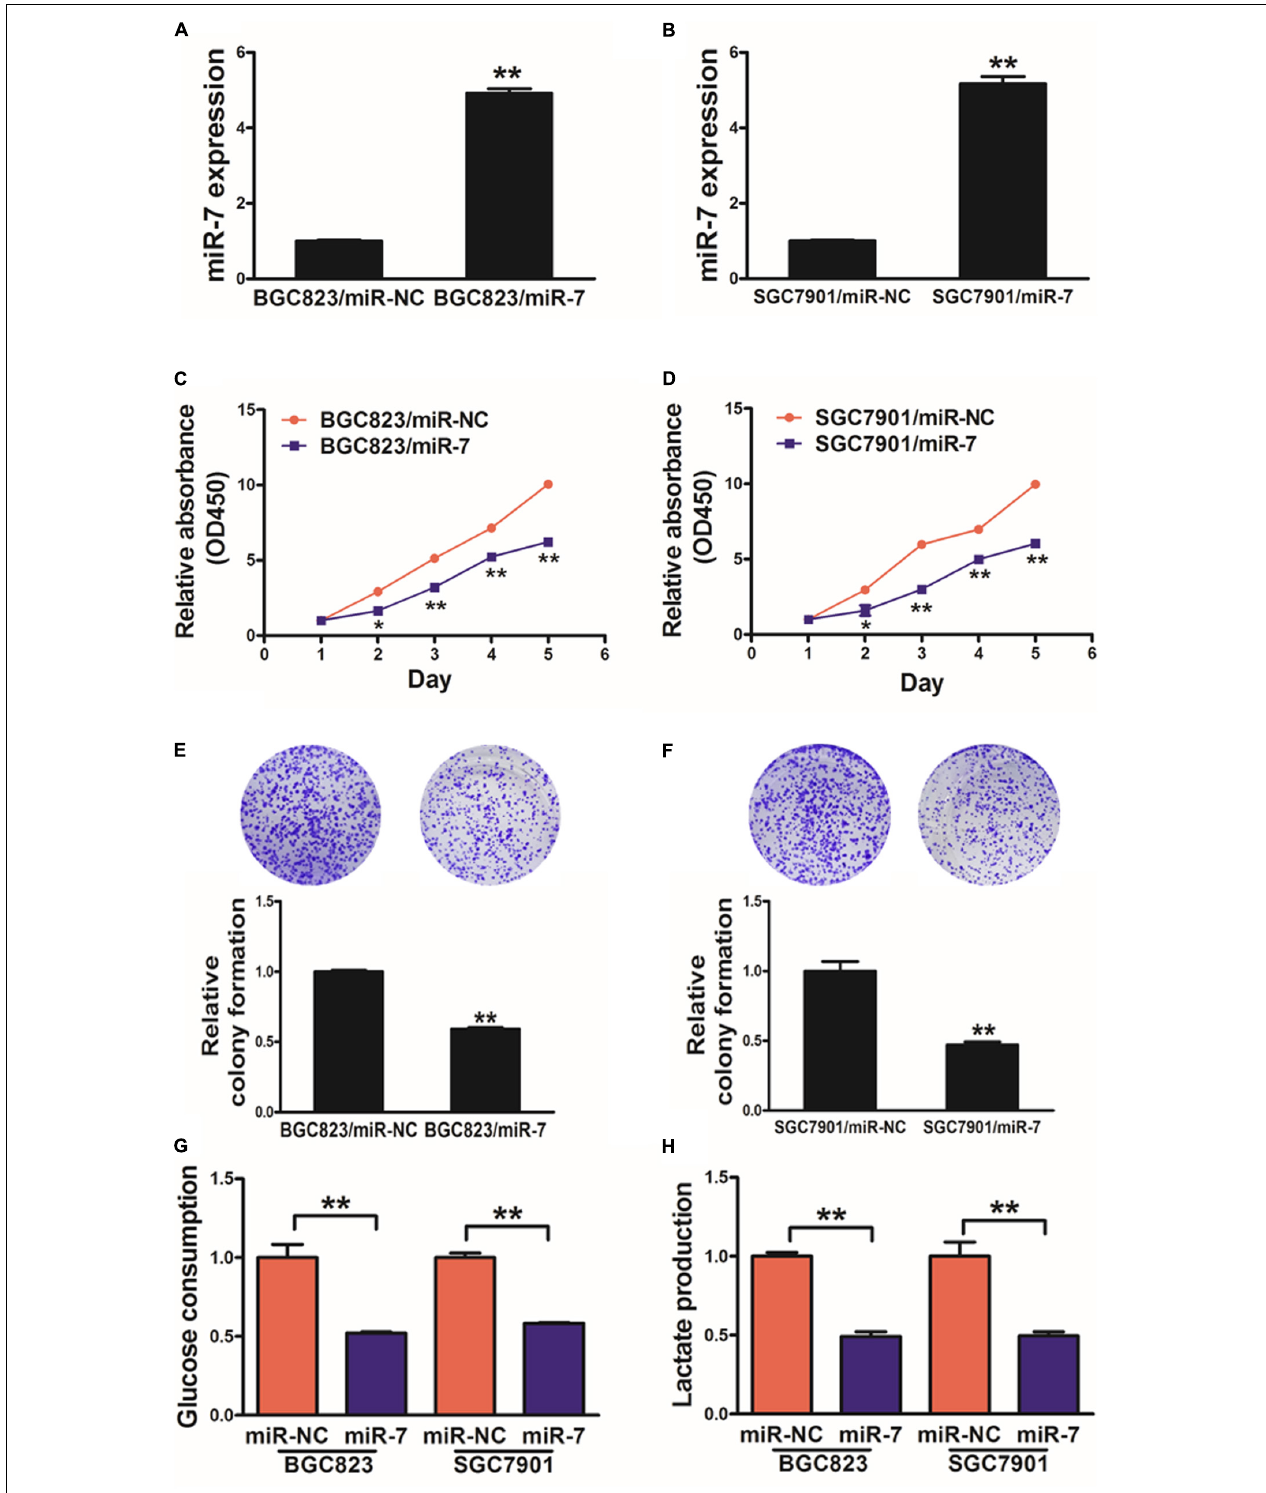
FIGURE 2 | miR-7 expression disrupts GC cell proliferation and glycolysis. (A,B) Relative miR-7 levels were assessed via qRT-PCR in BGC823 or SGC7901 cells transduced to stably express miR-7 or miR-NC. (C,D) A total of 2000 cells were added to wells of 96-well plates, and a CCK-8 kit was used to assess proliferation daily. (E,F) A colony formation assay was conducted using stably transduced cells. (G,H) Glucose utilization and lactate production were assessed for all cells. Three independent experiments were conducted in triplicate. Data are means ± SD. * P < 0.05; ** P < 0.01.